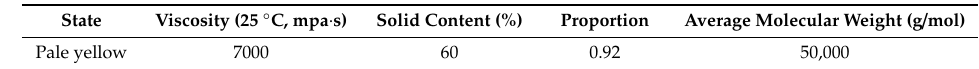
Table 4. Properties of latex SBR.